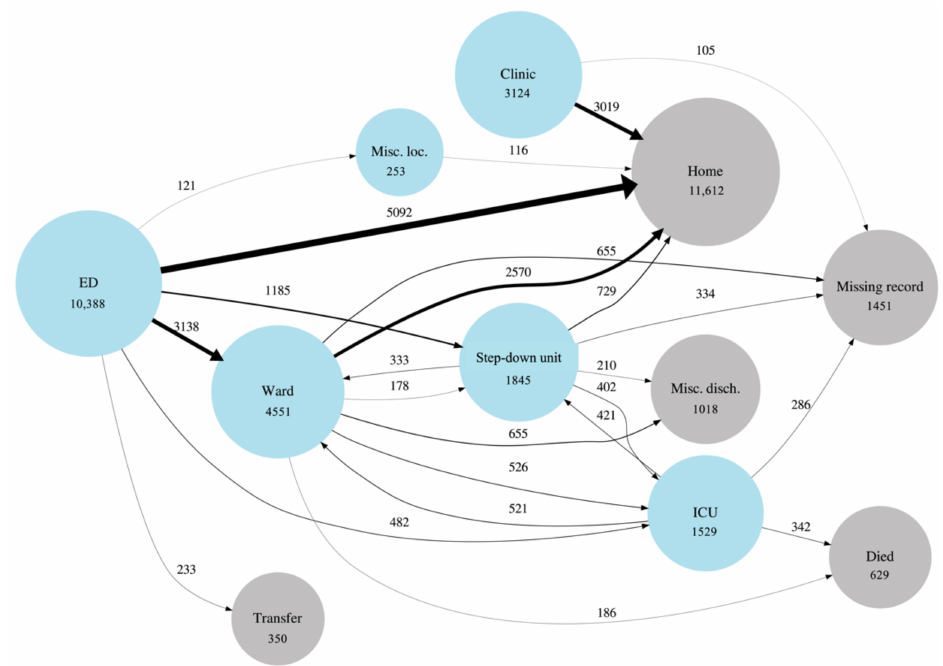
Figure 1. Graphical depiction of COVID patient flow through the healthcare system. Blue circles (nodes) represent location types within the system. Grey circles represent discharge dispositions. Circle diameters are proportional to the (natural log of the) number of patients who passed through a location type at least once during an encounter. Line (edge) widths are linearly proportional to the number of times a transition occurred and the edges are also labeled with this number. The “Misc. loc.” node stands for miscellaneous locations that have been grouped together due to low counts and for privacy purposes. The “Misc. disch.” node stands for miscellaneous discharge dispositions that have been grouped together. For visualization and privacy purposes, transitions are only shown when they have more than 100